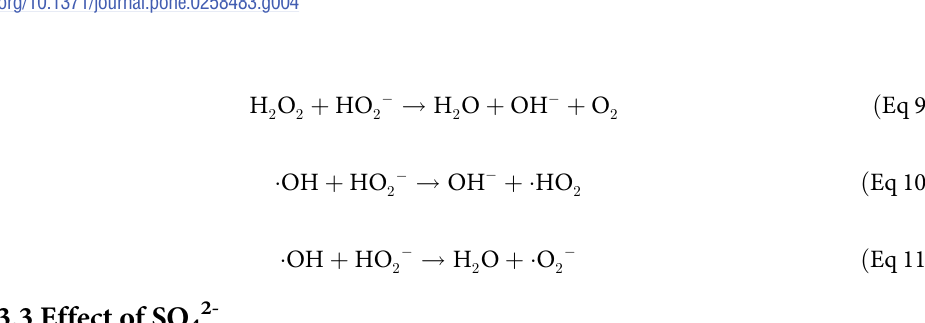
Fig 4. Effect of initial pH on the removal rate (a), kinetics constant (b) and linear fitting between kinetics constant and initial pH on the degradation of NIF via UV/H 2 O 2 . The error bars represent the standard deviation (n = 3).